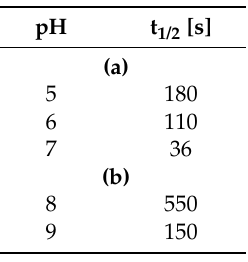
Table 1. ( a ) Half-life of Succinimidyl Iodoacetate (SIA) at different pH values; ( b ) Half-life